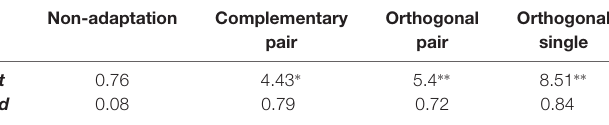
TABLE 2 | t and d statistics for comparison of the amplitudes of the first and second cycles of the sum of the 3 Hz and 6 Hz signal for each condition. Non-adaptation